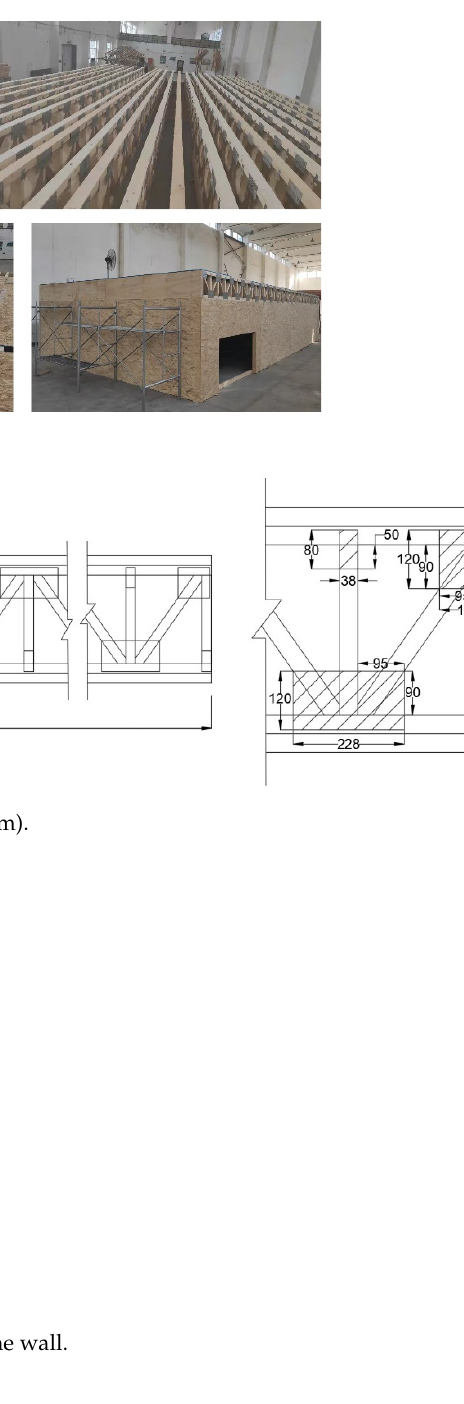
Figure 4. OSB layout. Different test floors were designed by installing strongbacks or partition walls into the initial floor system. The information for each group of test floors is shown in Table 1, and the schematic diagram is shown in Figure 5. The strongbacks were constructed from 40 mm × 140 mm cross-sectional size, J-level SPF specification material selected by visual inspection . It is installed in the vertical direction of the joists and connected to the truss web rod with three 80 mm wood screws from the top, middle, and bottom in the height direction of the strongbacks, as shown in Figure 6. The door on the surrounding wall could transport the partition wall. It is connected with the interface at the corresponding posi- tion on the surrounding walls, as shown in Figure 7. Table 1. Details of test floor structures. Floor